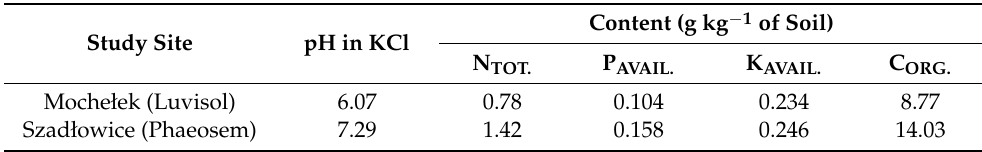
Table 4. Exchangeable acidity and the content of macroelements in soil before catch crop sowing— means for 2008 to 2010. Study Site pH in KCl